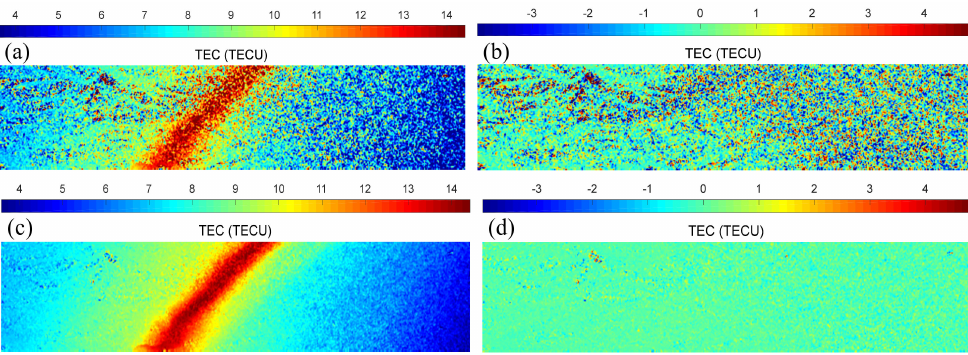
Figure 2. TEC retrieval in Alaska based on L-band SAR ( a ) and P-band SAR ( c ), with high systematic error level. The deviations between the retrieval and the true values (Figure 1a) are shown in ( b , d ).